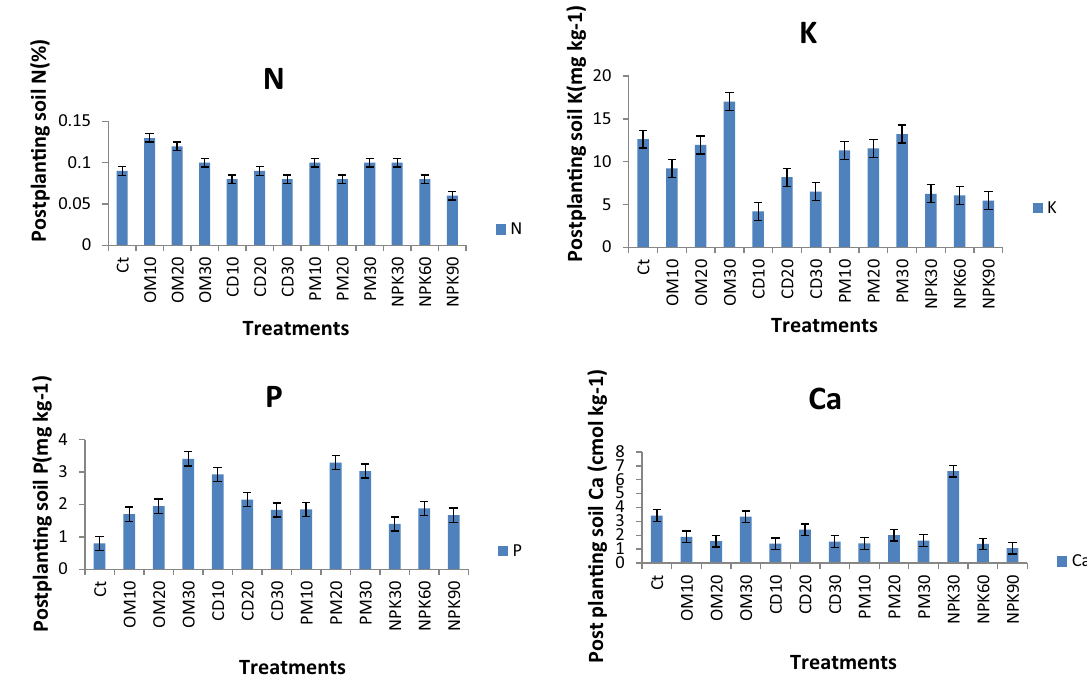
Fig. 1 Effect of different sources and rates of organic and inorganic fertilizers on post-planting soil properties of Moringa oleifera